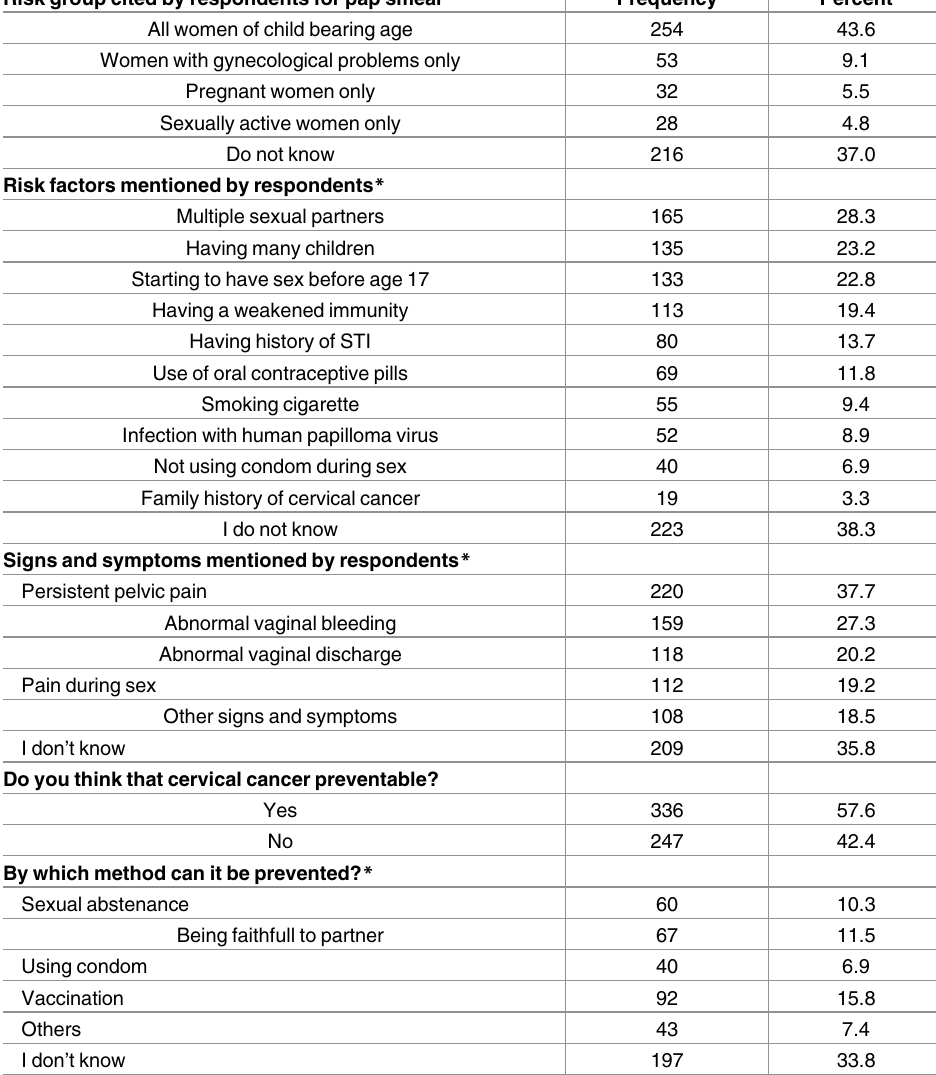
Table 2. Knowledge of respondents about risk groups, risk factors, signs and symptoms and meth- ods of prevention of cervicalcancer in Hossana town, Hadiya Zone, June 2015. Risk group cited by respondents for pap smear * Frequency All women of child bearing